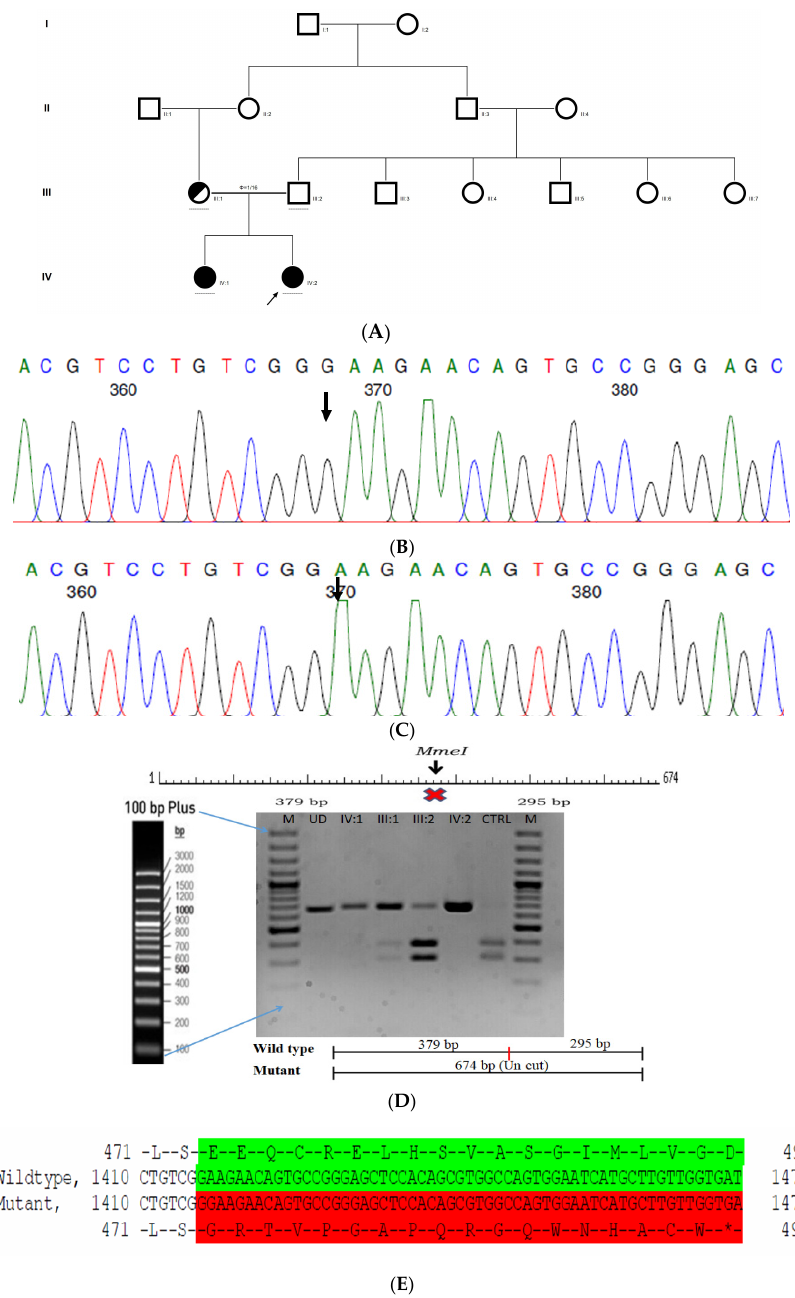
Figure 4. Pedigree of CCE27 ( A ). Partial sequence chromatogram of the proband (( B) , IV:1) and control subject ( C ), P3H2 exon 9, depicting a homozygous mutation (c.1417 dup; p.Glu473Glyfs*19). Mutant and wildtype peaks are marked by an arrow. RFLP analysis of the mutation p.Glu473Glyfs*19 in P3H2 ( D ), which shows co-segregation among the affected family members (IV:1 and IV:2), while the parents are carriers (III:1 and III:2). Control (DKC192) (CTRL) shows complete digestion. UD—undigested PCR Product. The variation leading to frame shift mutation (red) compared with the wildtype sequence (green) ( E ).